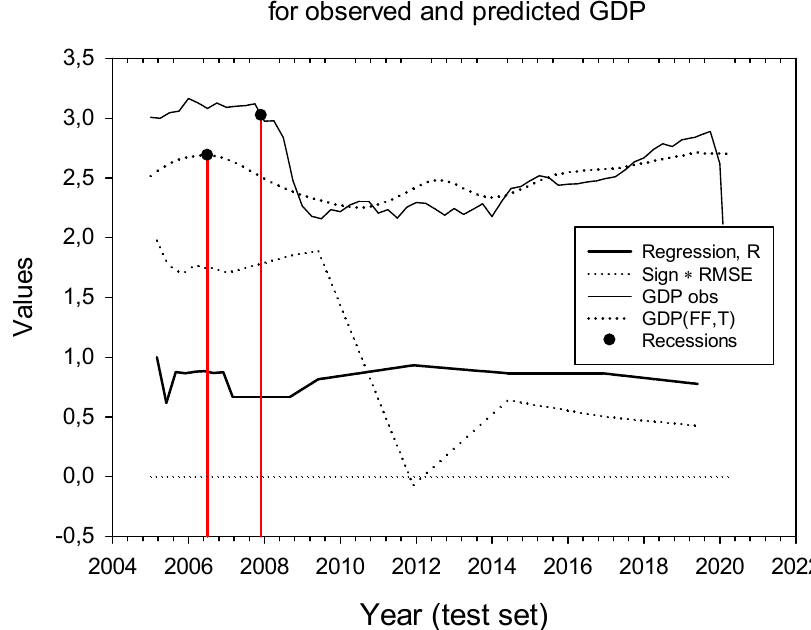
Figure 3. Comparison of observed GDP with predicted GDP(T, FF). The drop-down lines show the NBER 2008 recession date (right) and the date when the predicted GDP starts to decline (left). The regression coefficient, R, between observed and predicted GDP is always positive and ends in quarter 60 at R = 0.776, (R 2 = 0.60). The average root mean square error is calculated with a sign so that if predictions are below observed values, the RMSE is positive. Regressions and RMSE are calculated at quarters 1 to 8, 12, 16, 20, 30, 40, 50 and 60.